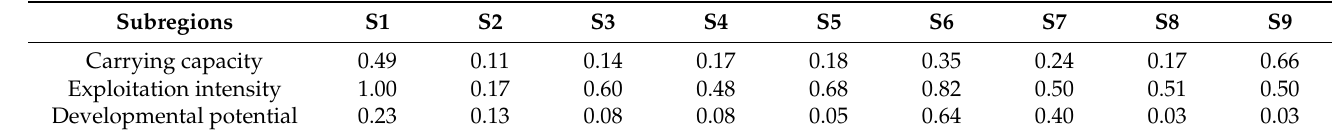
Table 6. Scores of the comprehensive evaluation indicators.